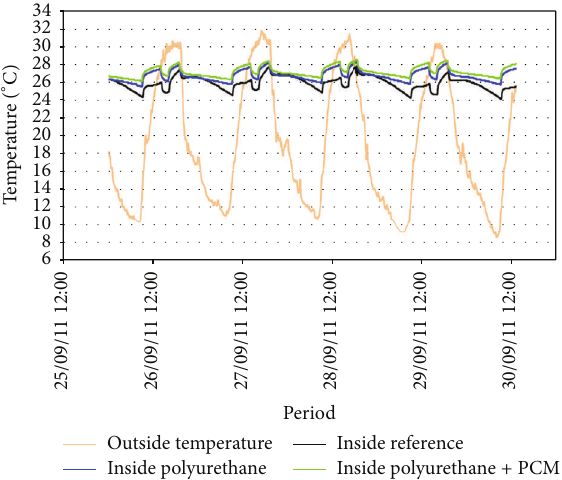
Figure 8: Free floating with internal loads (office profile): inside and outside